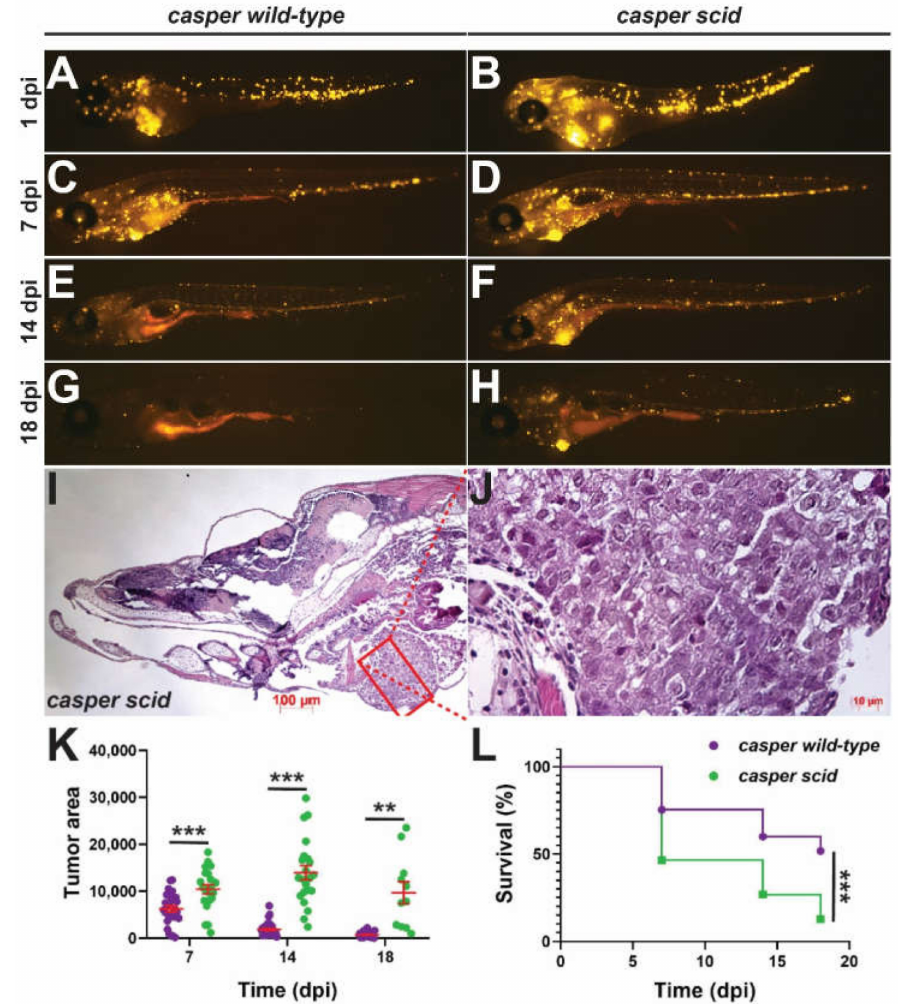
Figure 4. Effect of Il-2r γ c.a ablation on tumor immunity. ( A – H ) Representative casper fish har- boring il2rga wt/wt ( casper wild-type ) ( A , C , E , G ) or il2rga mdu2/mdu2 ( casper scid ) ( B , D , F , H ) injected with fluorescently-labeled human HCT116 colorectal cancer cells imaged at the indicated days post in- jection (dpi). ( I – I’ . Histology of a representative tumor from a casper scid fish at 18 dpi at low magnification (5 × , I ) and of the boxed area at high magnification (40 × , J ). ( K ) Quantitation of tu- mor area showing results for individual embryos, with mean and SEM in red. ( L ) Kaplan–Meier survival curve of transplanted fish. For panels ( K – L ), statistical significance is indicated (**: p < 0.01, ***: p < 0.001, n =